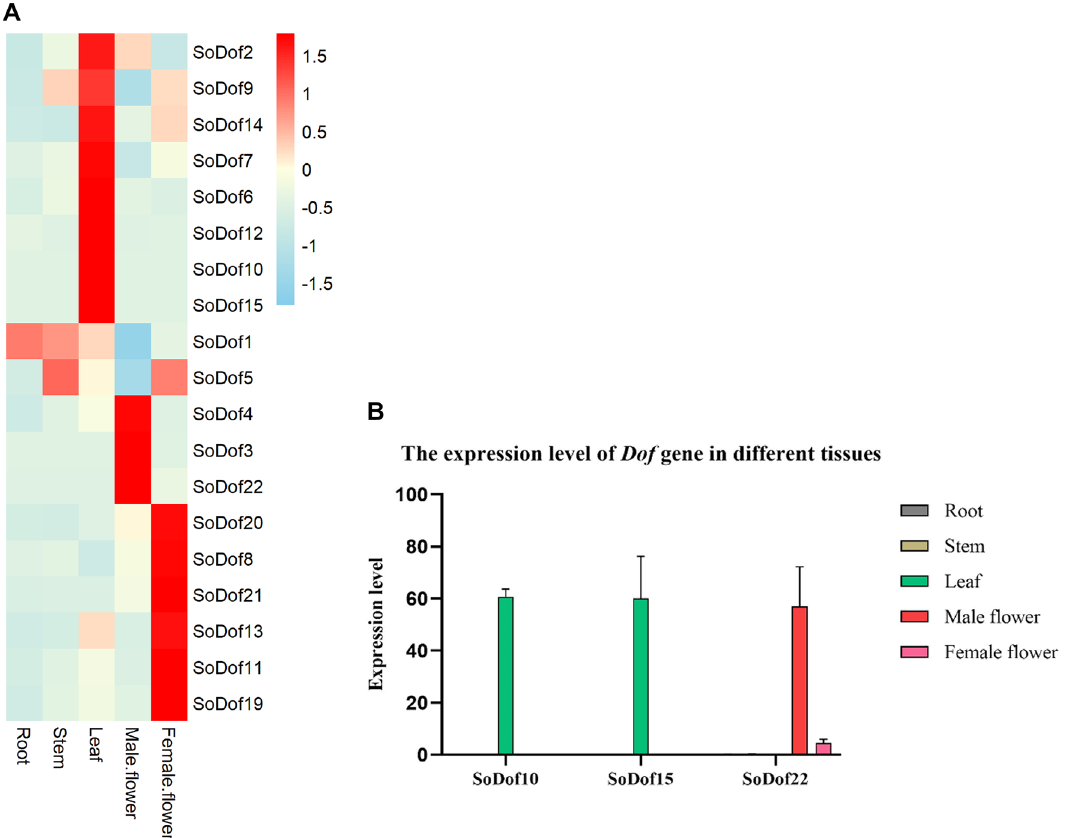
Figure 6. The tissue-specific expression of Dof genes in Spinach by qRT-PCR. ( A ) Expression level of SoDofs . The color scheme used to present expression level is sky-blue/red: light-yellow boxes indicate low variation in gene expression, sky-blue indicate a fold decrease, and red boxes indicate a fold increase in relation to mean value. The expression value were calculated as the arithmetic mean. ( B ) The expression level of SoDof10 , SoDof15 and SoDof22 in different tissues. The Y-axis indicates relative expression level and the X-axis indicated different tissues: root (gray); stem (light brown); leaf (green); female flower (red); male flower (pink). The error bars were caculated based on three biological repiticates using standard deviation. Figure ( A ) was made by R package; ( B ) was made by Graphpad